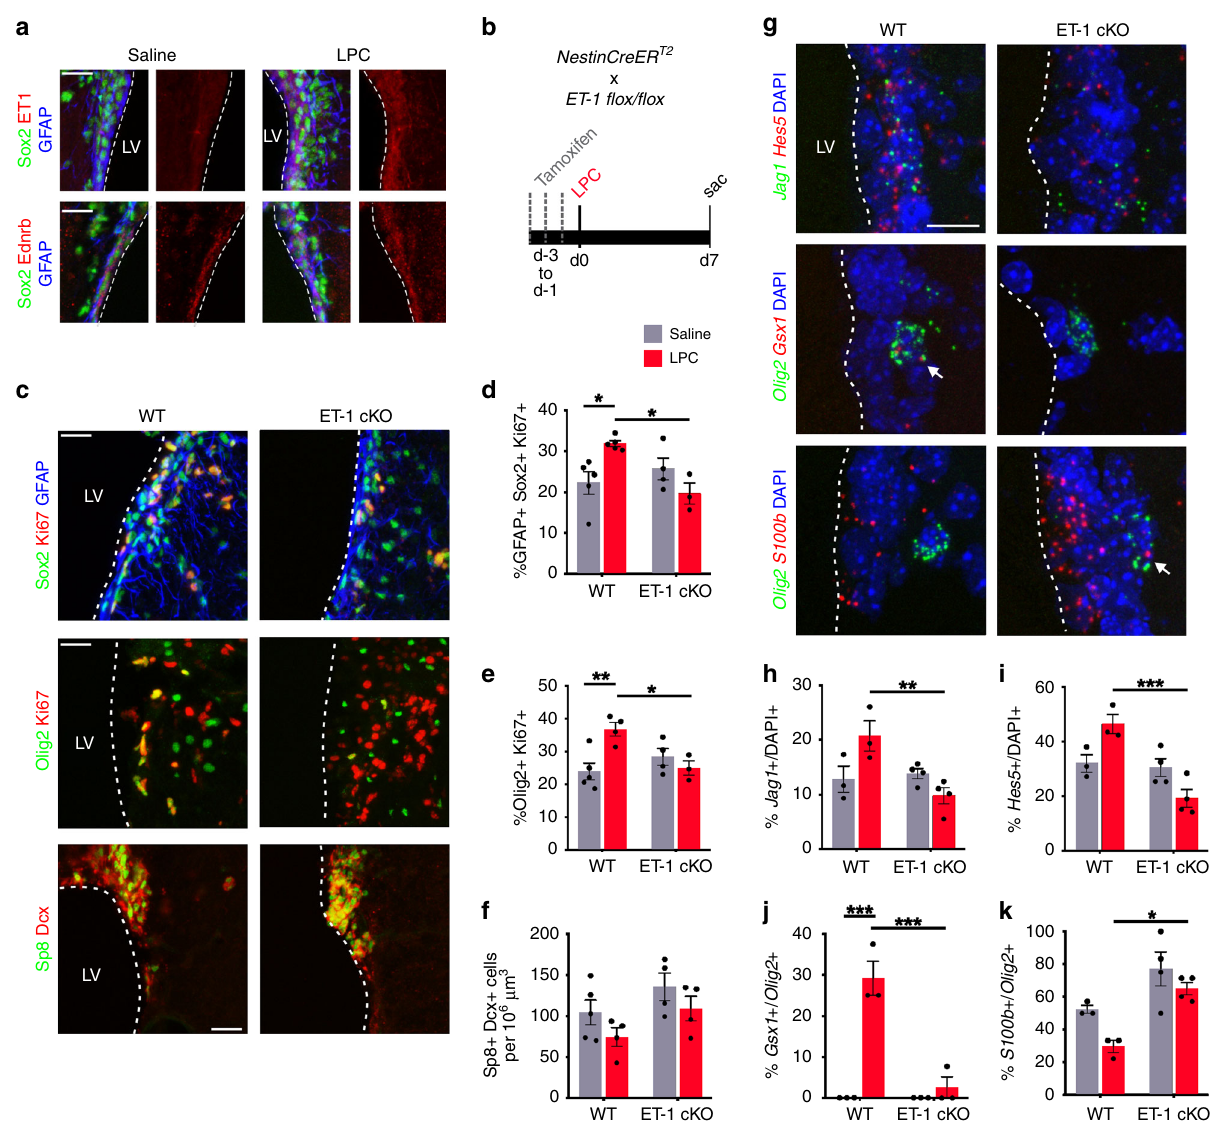
Fig. 7 ET-1 signaling is reactivated in the adult mouse SVZ following demyelination. a Expression of ET-1 and Ednrb in the adult SVZ of WT mice 7 days following injection of saline or lysolecithin (LPC) into the SCWM. Images are representative of three WT mice. Scale bar = 25 μ m. b Experimental strategy. c Coronal sections of adult WT and ET-1 cKO SVZ 7 days following LPC injection. Scale bar = 25 μ m. d Quanti fi cation of the percentage of proliferating NSCs in the SVZ (Saline: n = 5 WT, 5 ET-1 cKO mice. LPC: n = 5 WT, 3 ET-1 cKO mice). * p value = 0.0284 (WT saline versus WT LPC); * p value = 0.0156 (WT LPC versus ET-1 cKO LPC) (two-way ANOVA with Tukey ’ s multiple comparisons test). e Quanti fi cation of the percentage of proliferating OPCs in the SVZ (Saline: n = 5 WT, 4 ET-1 cKO mice. LPC: n = 4 WT, 3 ET-1 cKO mice). ** p value = 0.0097; * p value = 0.0364 (two-way ANOVA with Tukey ’ s multiple comparisons test). f Quanti fi cation of Sp8 + Dcx + NPCs in the SVZ (Saline: n = 5 WT, 4 ET-1 cKO mice. LPC: n = 4 WT, 4 ET-1 cKO mice). g RNAscope labeling of coronal sections of adult WT and ET-1 cKO SVZ 7 days following LPC injection. Arrows point to red puncta within Olig2 + cells. Scale bar = 10 μ m. h Quanti fi cation of the percentage of Jag1 + cells in the dorsal SVZ ( n = 3 WT, 4 ET-1 cKO mice). ** p value = 0.0086 (two-way ANOVA with Tukey ’ s multiple comparisons test). i Quanti fi cation of the percentage of Hes5 + cells in the dorsal SVZ ( n = 3 WT, 4 ET-1 cKO mice). *** p value = 0.0009 (two-way ANOVA with Tukey ’ s multiple comparisons test). j Quanti fi cation of the percentage of Gsx1 + OPCs in the dorsal SVZ ( n = 3 mice both groups). *** p value = 0.0001 (WT saline versus WT LPC); *** p value = 0.0003 (WT LPC versus ET-1 cKO LPC) (two-way ANOVA with Tukey ’ s multiple comparisons test). k Quanti fi cation of the percentage of S100b + OPCs in the dorsal SVZ ( n = 3 WT, 4 ET-1 cKO mice). * p value = 0.0187 (two-way ANOVA with Tukey ’ s multiple comparisons test). LV lateral ventricle. Data are presented as mean values ± SEM. Source data are provided as a Source Data fi RNAseq analysis . The quality of the raw fastq reads from the sequencer was RNAseq library preparation and sequencing . The RNA samples were sent to the evaluated using FastQC. HISAT2 (version 2.1.0) 47 was used to map the reads to the Penn State Hershey Genome Sciences and Bioinformatics Facility at Penn State College of Medicine. The RNAseq libraries were prepared using the NEXT fl ex reference mouse genome (GRCm38/mm10). The output SAM fi les were sorted by Rapid Directional RNA-Seq Kit. The libraries were indexed (Unique Dual Index coordinate and converted to BAM fi les using SAMtools (version 1.3) 48 . Duplication Barcodes) and pooled together for sequencing on an Illumina NovaSeq 6000 using reads were marked using Picard (version 2.17.6) MarkDuplicates. The mapped paired-end reads of 50 bp. The raw sequences were de-multiplexed based on the reads were counted along with the multimapping and multioverlapping reads using index sequence and trimmed.